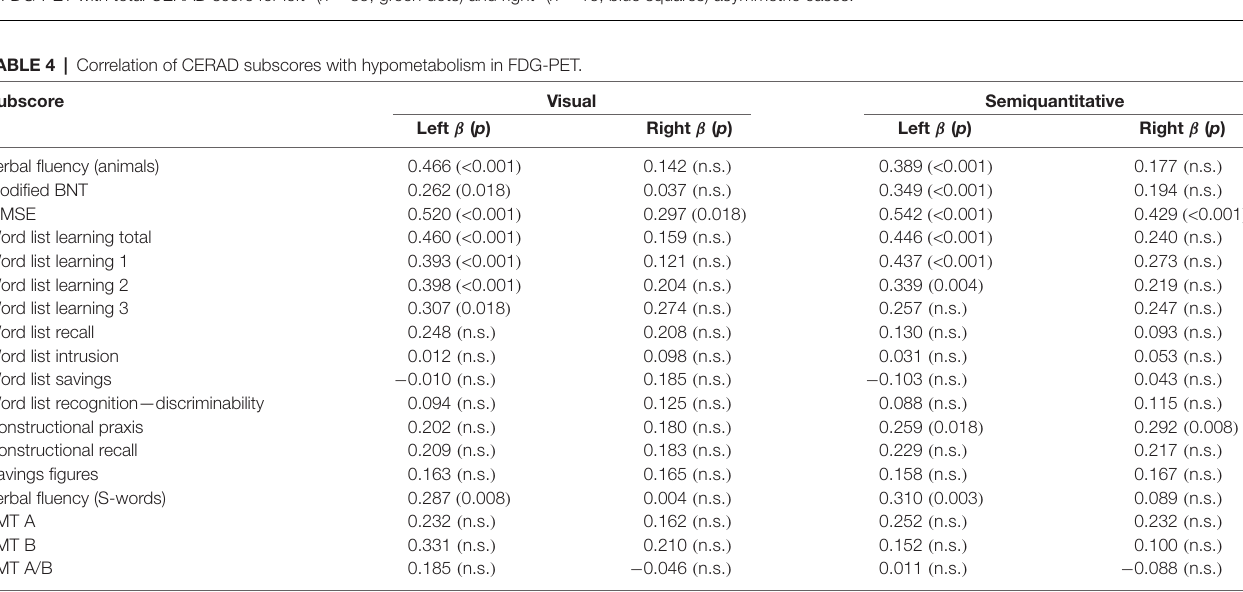
FIGURE 2 | Comparison of cases with dominant right- and left-lateralization. Correlation plots show the functions of (A) visual FDG-PET and (B) semiquantitative FDG-PET with total CERAD score for left- ( n = 35, green dots) and right- ( n = 16, blue squares) asymmetric cases.